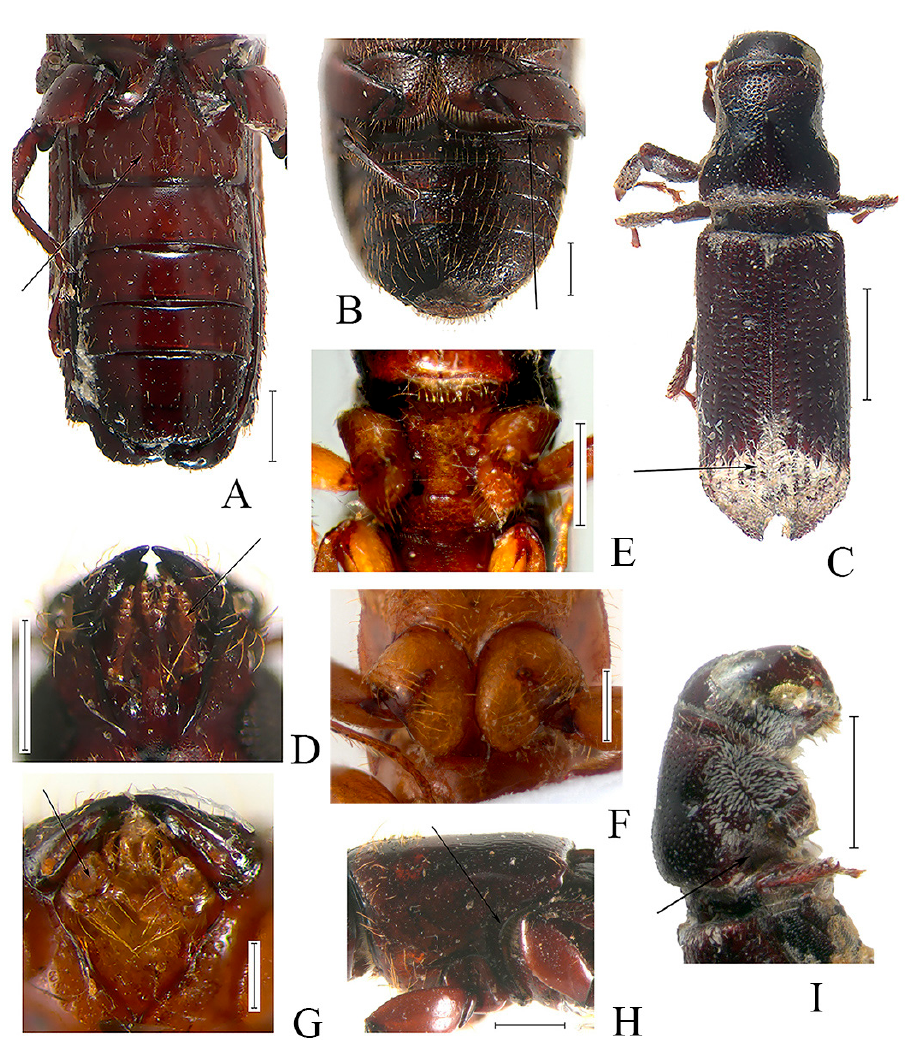
—Posterior margin of prosternum laterally weakly curved (Figure 4H). Metacoxal cavities strongly encroaching on first ventrite. Second ventrite shorter than third ventrite. Protibia with transverse, coarse, costate ruga. Third tarsomere bilobed. Five-segmented antennal funicle. Elytral declivity obliquely subtruncate and armed………… Schedlariini 3. Maxilla with lacinia and galea combined into one mesal element (Figure 4G). . . . . . . . . —Maxilla, lacinia, and galea separated (Figure 4D) ( Tesserocerinae)………………..4 4. Procoxae contiguous (Figure 4F). Metacoxal cavities strongly encroaching on first ventrite. Second ventrite shorter than third ventrite (Figure 4B). Four-segmented antennal —Metacoxal cavities not strongly encroaching on first ventrite. Second and third ventrites subequal or second shorter than the third (Figure 4A). Two–three-segmented antennal